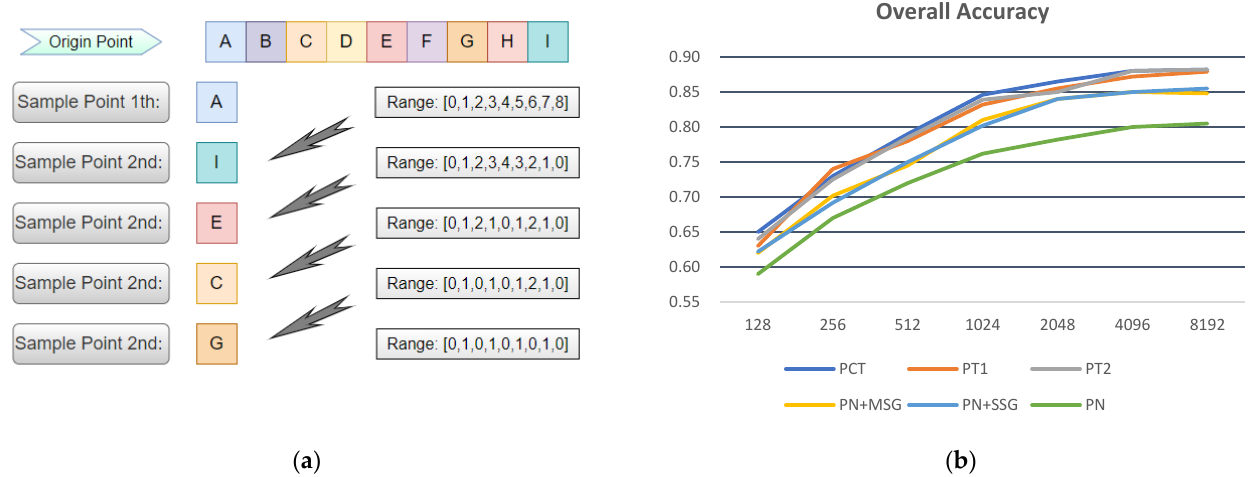
Figure 13. ( a ) Schematic diagram of farthest point sampling algorithm affected by point density; ( b ) the overall accuracy of different deep learning algorithms increases with an increase in the number of sampling points.